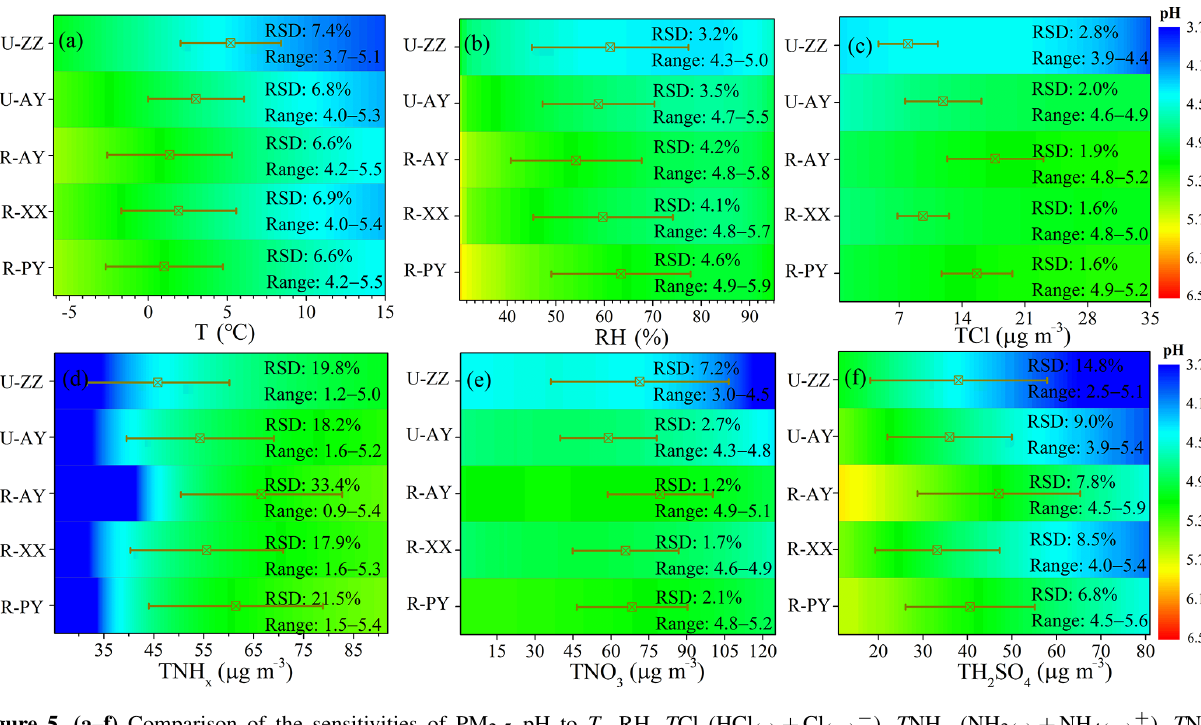
Figure 5. (a–f) Comparison of the sensitivities of PM 2 . 5 pH to T , RH, T Cl (HCl ( g ) + Cl ( aq ) − ), T NH x (NH 3 ( g ) + NH 4 ( aq ) + ), T NO 3 (HNO 3 ( g ) + NO 3 ( aq ) − ), and T H 2 SO 4 (replaced by observed SO 42 − ) among the five sites. A given range for a variable for all sites with corresponding average values of other parameters was used as input to the ISORROPIA-II model. The range of the x axis is close to the observed minimum and maximum values in Case 2 (Table S4 in the Supplement). The color scale bar represents the pH values. The relative standard deviation (% RSD) and range (Range) represent the sensitivity degree of pH to this variable and range (min–max) of the re-predicted pH value in the test, respectively. The square plots on the graph represent the average values of each variable observed in Case 2 with standard deviation as an error bar. Table 4. Sensitivity of pH to input data. The real-time measured values of a variable and the average values of other parameters during Case 2 were input into the ISORROPIA II. The degree of sensitivity was represented as the relative standard deviation (% RSD) of the re-calculated pH values; higher RSD implied higher sensitivity of this factor to pH and thus is more important for local pH. T H 2 SO